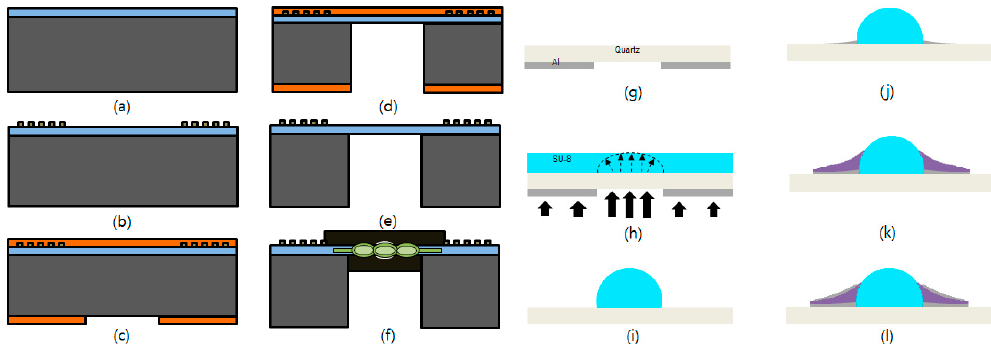
Figure 5. Fabrication procedure. ( a ) LN waveguide bonding onto Si wafer, ( b ) Al patterns for wide bandwidth IDTs, ( c ) PR patterns for masking and protection layer during DRIE process, ( d ) DRIE, ( e ) cleaning with microstriper, ( f ) light blocker assembling for effective light coupling, ( g ) Al patterns for lens, ( h ) SU ‐ 8 spin coating and then UV exposure via proximity lithography, ( i ) developing process to form hemisphere shape of the polymer, ( j ) Al patterns, ( k ) PZT patterns via RF sputter, and ( l ) Al patterns for sandwiched PZT by two electrodes and lift ‐ off.